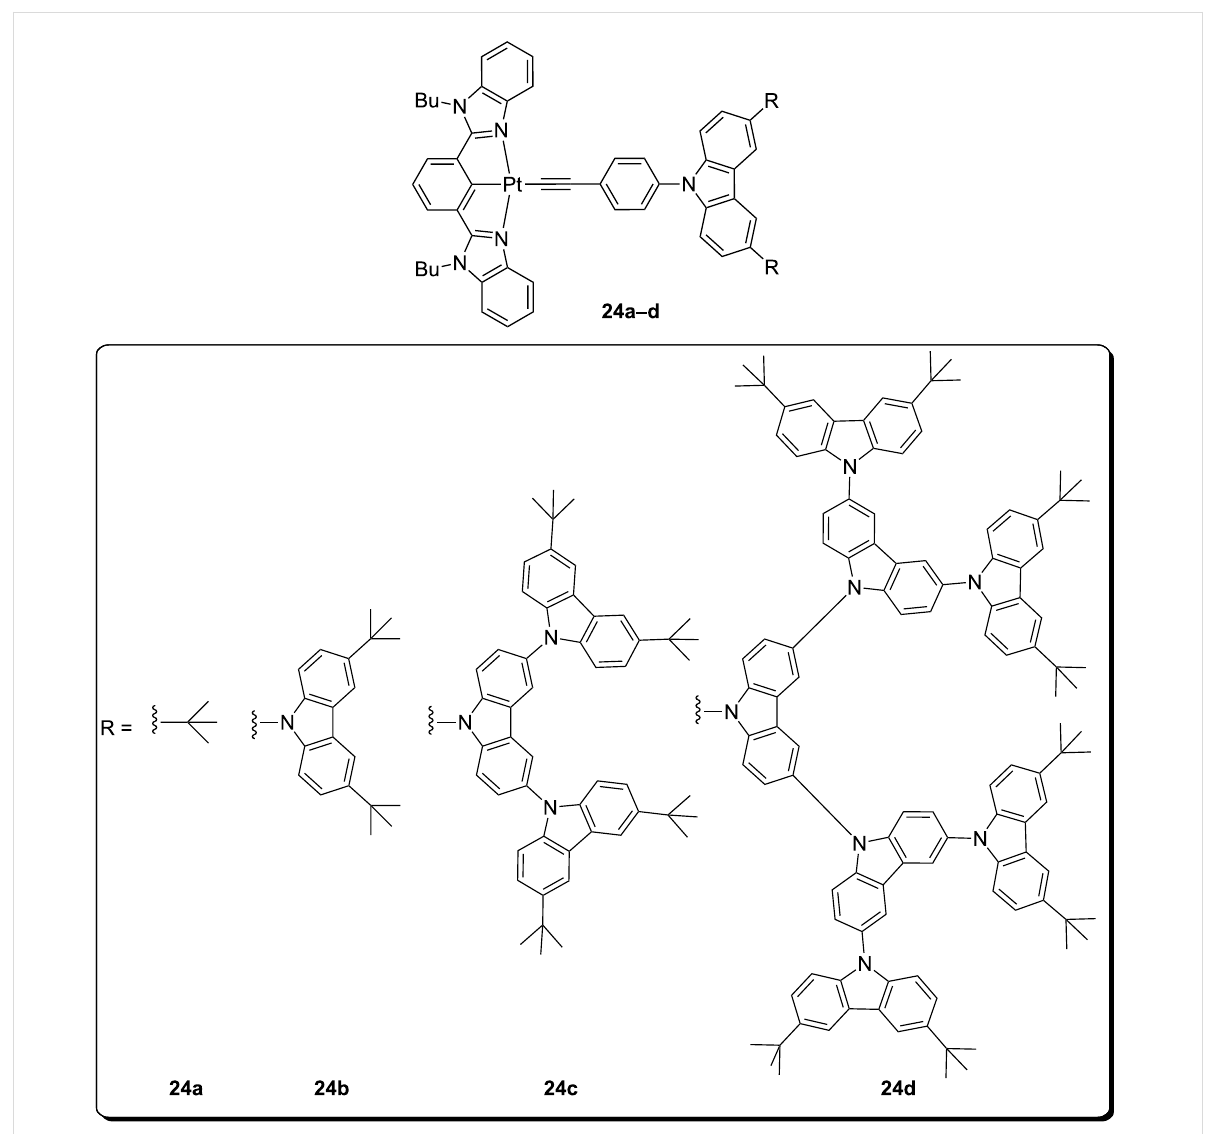
Figure 12: Molecular structure of dendritic carbazole-containing alkynyl-platinum(II) complexes 24a–d